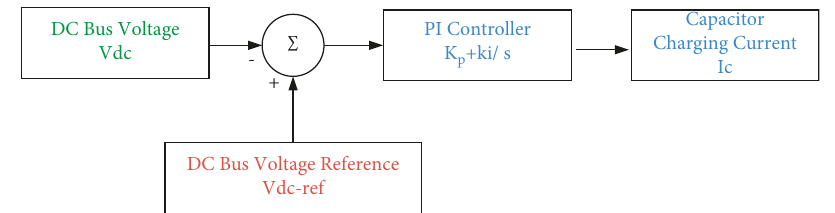
Figure 26: PI-Controller to maintain DC Bus